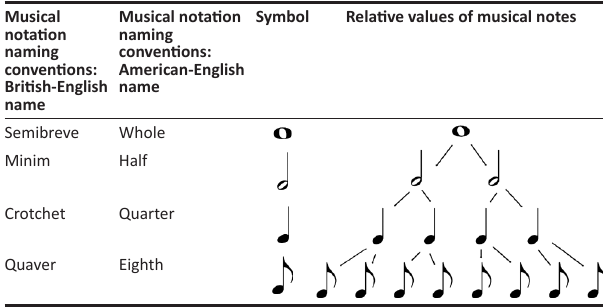
FIGURE 1: Representation of note value names and relative